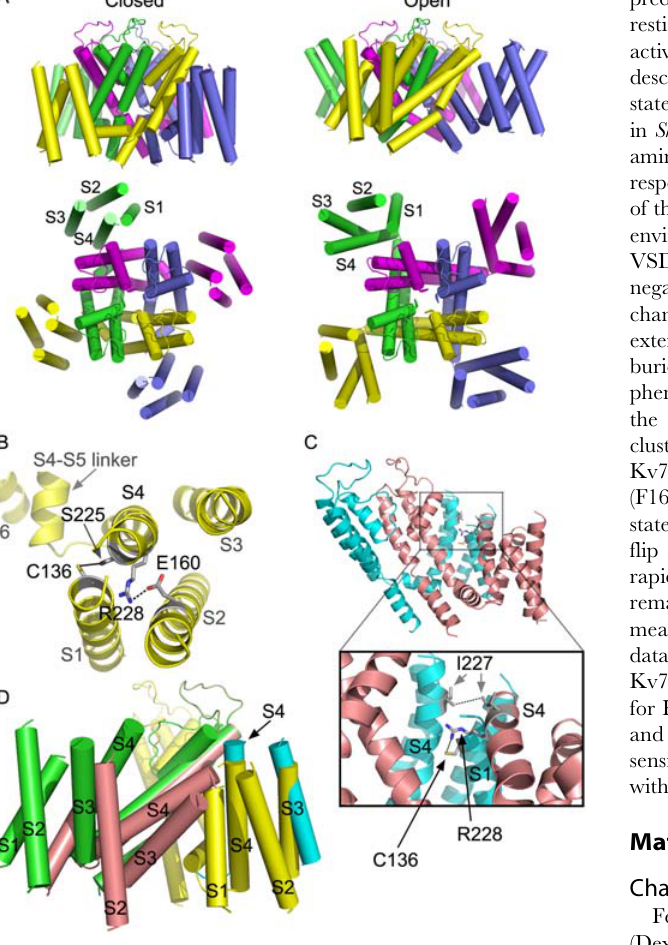
Figure 9. Plausible structural models accounting for the gating conformations of the voltage sensor domains of Kv7.1. ( A ) The closed (left) and open (right) conformations of Kv7.1 in side view (upper part) or top view (lower part). Each subunit is colored differently while alpha helices are shown as cylinders. ( B ) Top view of a subunit that reflects the closed state, where R228 becomes close to Glu160 (2.7 A˚) and S255 to Cys136 (5.1 A˚) within the same subunit. The indicated side chains are colored in CPK (grey, blue, red and yellow colors correspond to carbon, nitrogen, oxygen and sulfur atoms, respectively). ( C ) Side view of two adjacent subunits, which represent an intermediate open state (salmon) and an intermediate closed state (cyan). The two subunits are viewed from the inner part of the pore in horizontal outward direction. The inset shows the distance between Ile227 of two neighboring VSDs (5.2 A˚) as well as the distance between R228 and Cys136 of the adjacent VSD (4.6 A˚). ( D ) Adjacent VSDs in the open state (green), the intermediate open state (salmon), the intermediate closed state (cyan) and the closed state (yellow). Note that the VSD of the intermediate open state (salmon) tilts towards the neighboring VSD to interact with the S4 of the intermediate closed state (cyan), which undergoes axial rotation and translation from the closed state